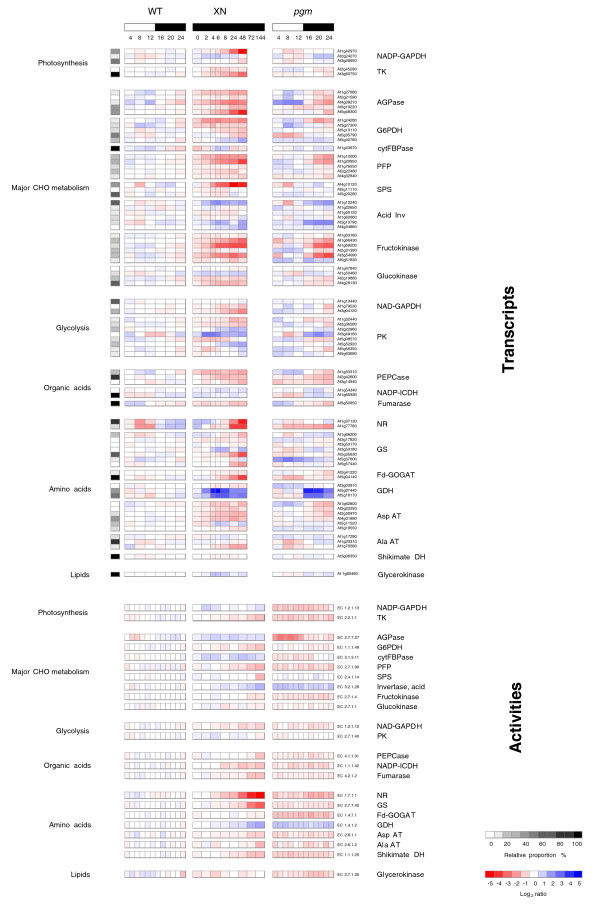
Heat map representing the changes in transcript levels and in the corresponding 23 enzyme activities in rosettes of Arabidopsis. Samples were taken from Col0 WT plants and Col0 pgm growing in a 12 h night and 12 h day cycle, throughout one day and night cycle, and in WT plants transferred to an extended night (XN). Log2 ratios were calculated for each value, by dividing it by the average of diurnal WT values and applying the logarithm (base 2). Log2 ratios give the intensity of the blue or red colors, according to the scale from the legend. Relative proportions among isoforms were calculated using the entire dataset and give the intensity of the gray color. These data are taken from [4] and [37]. CHO, carbohydrate.